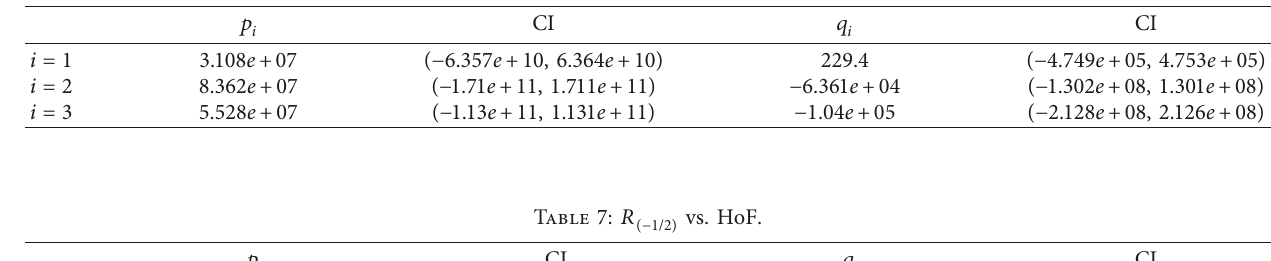
Table 6: R ( 1/2 ) vs. HoF.